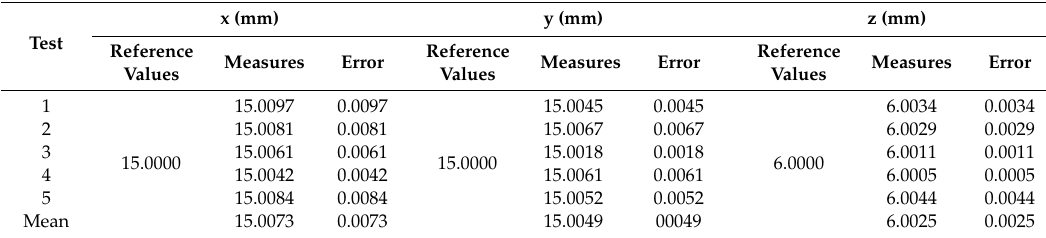
Table 1. Accuracy analysis of 3D-printed